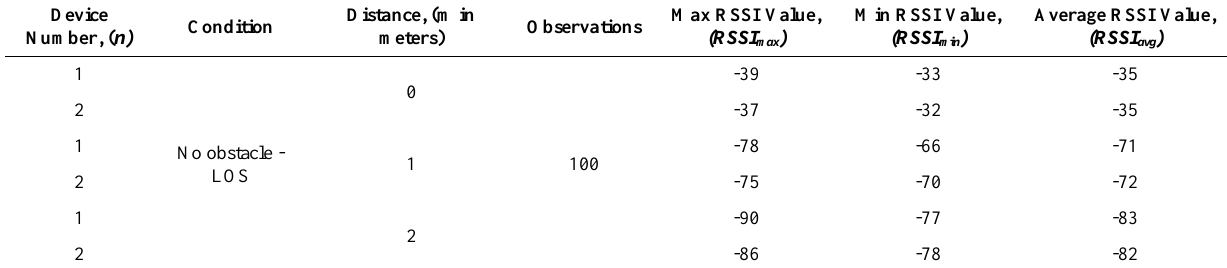
Table 3. Results from Stage 1